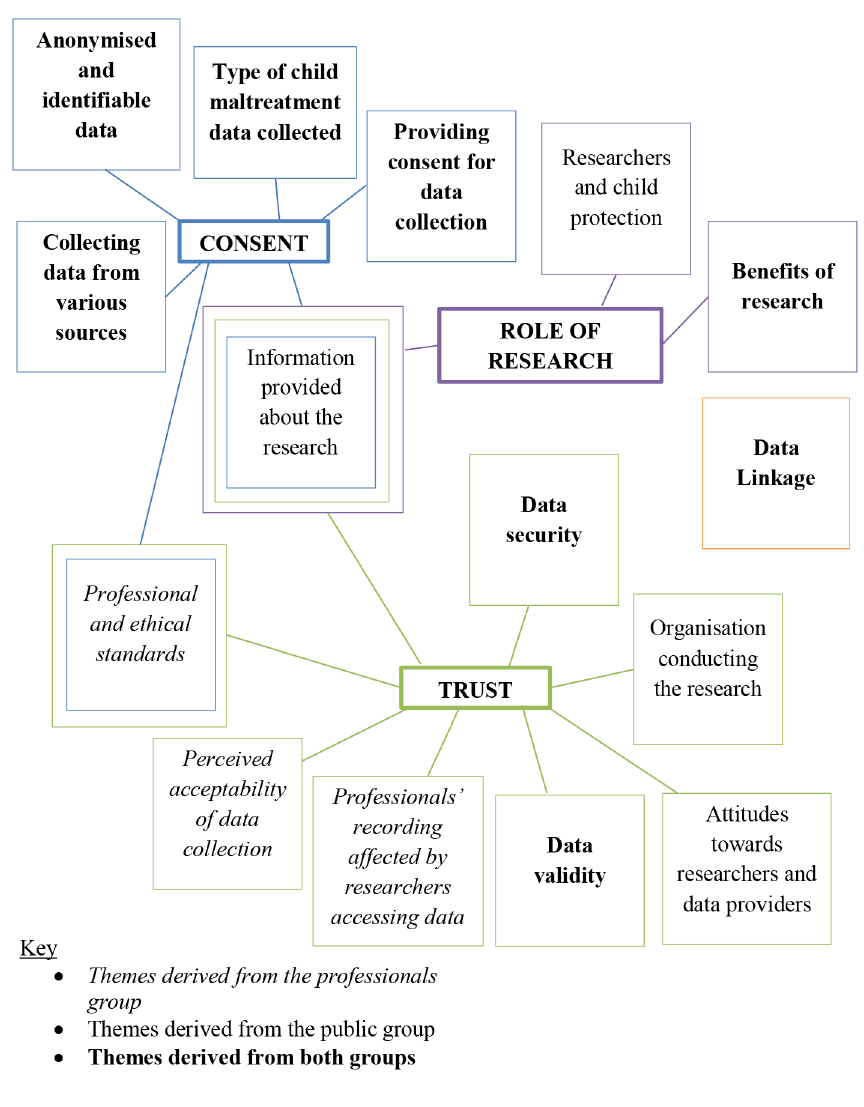
Figure 1: Coding framework - major themes and